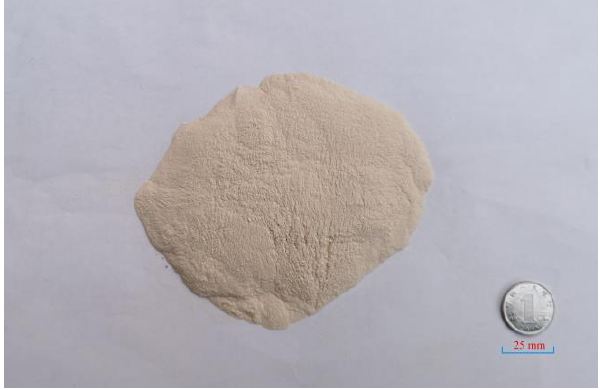
Figure 1. Biological waste: eggshell powder.